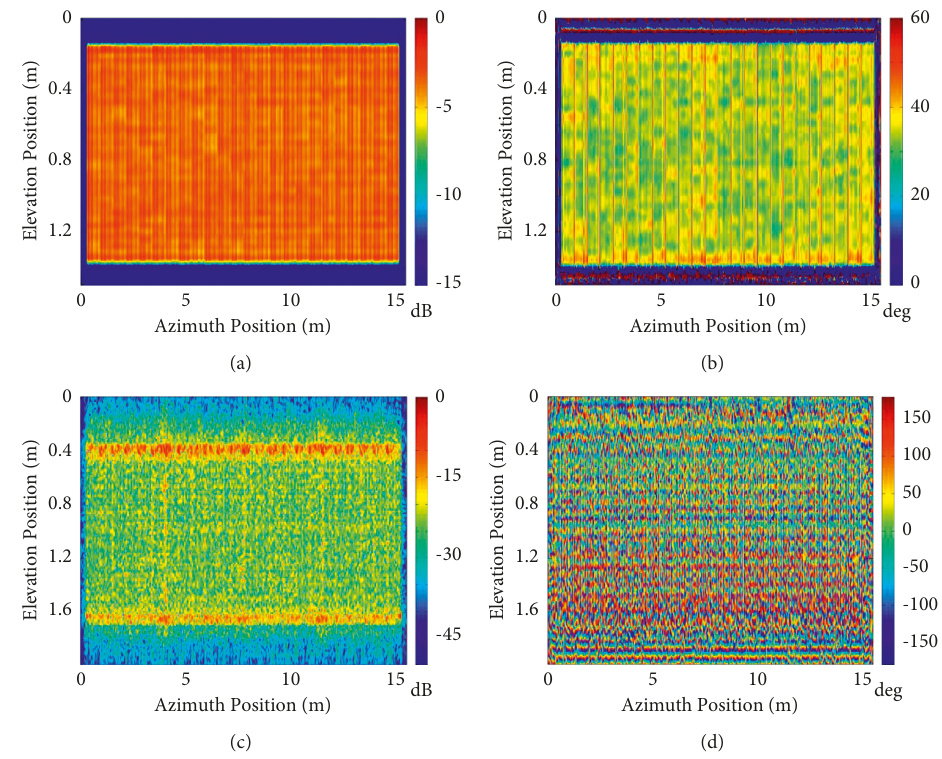
Figure 4: (a) Normalized amplitude of the aperture field for H-polarization. (b) Phase of the aperture field for H-polarization. (c) Normalized amplitude of the aperture field for cross-polarization. (d) Phase of the aperture field for